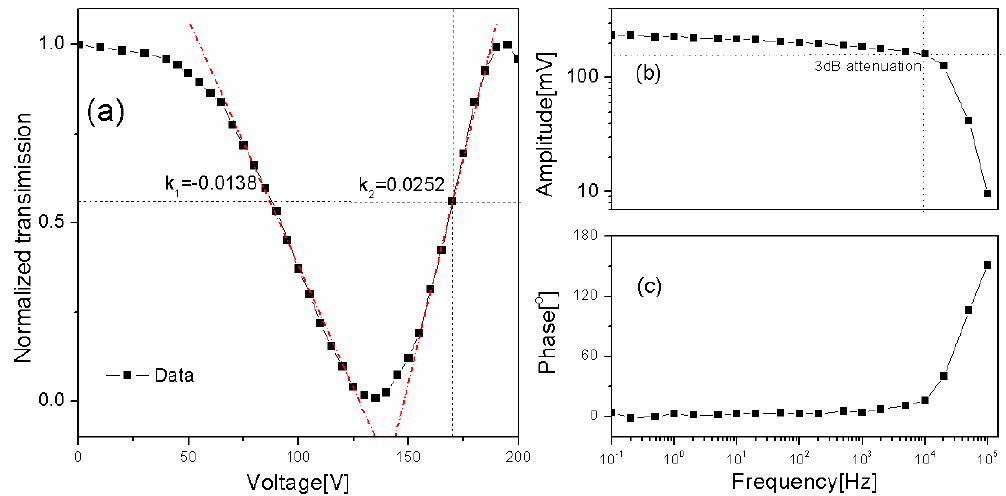
Figure 2. ( a ) Transmission of linearly polarized light through the intensity stabilizer as a function of the voltage applied to the fiber polarization rotator ( f -PR); Frequency dependence of the ( b ) amplitude and ( c ) phase responses of the PR. Solid squared markers represent individual data points. Blue solid lines make up curves to guide the eye through the individual data points. The blue dotted lines in panel (a) represent the x- and y-values of the nominal working position of the f -PR while those in panel (b) indicate the amplitudes and frequency for the 3-dB response. The dashed dotted lines represent the linear responses at the positions for close-to-linear response.